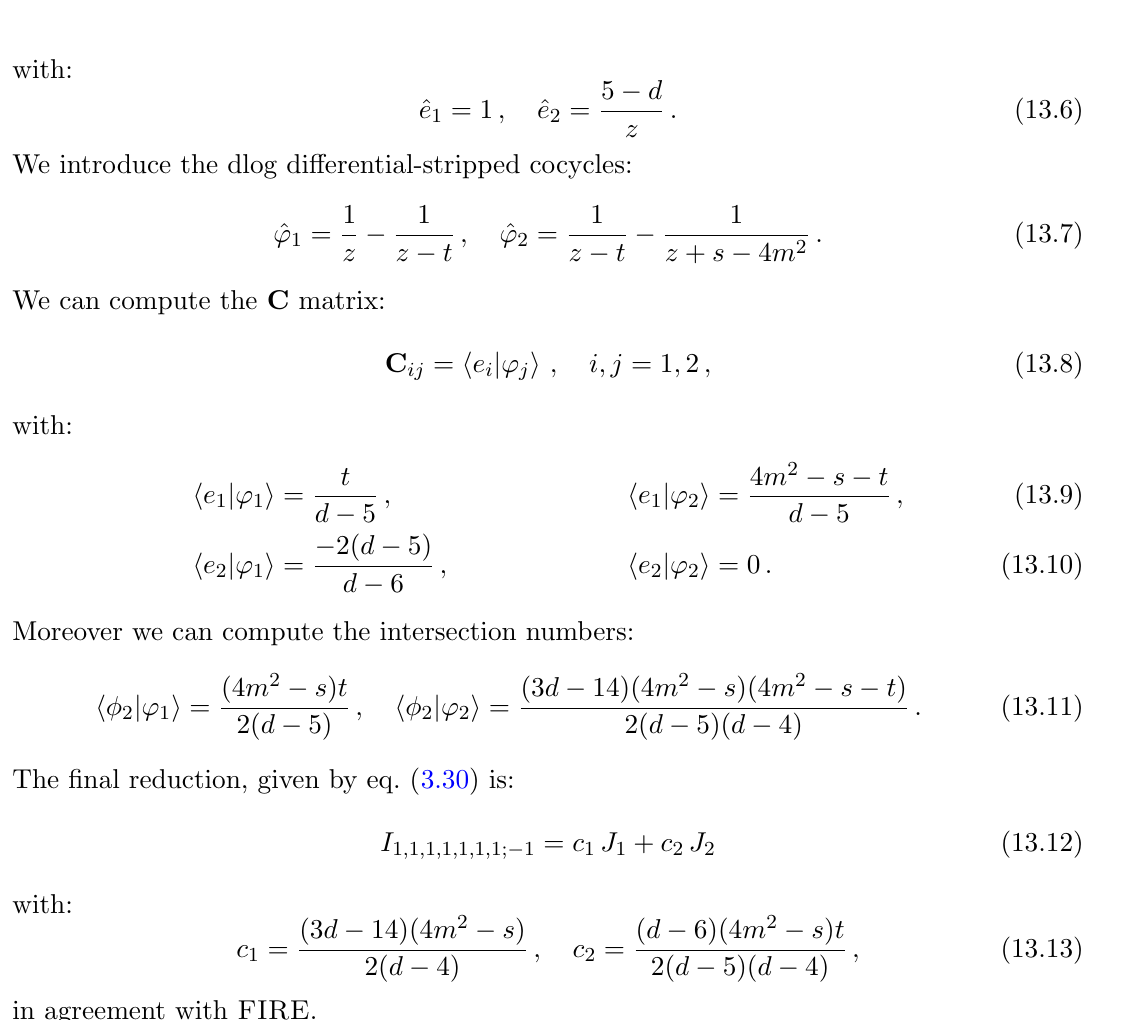
Figure 12. Bhabha | second planar